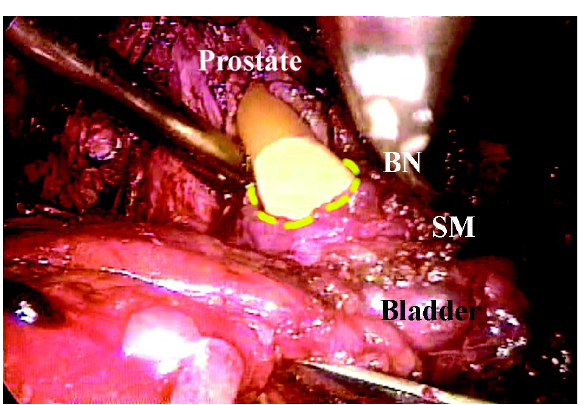
Figure 9 – Identification and opening of the anterior layer of Denovilliers’ fascia posterior to the prostate with viewing of vasa deferentia. P= prostate, DF= Denovilliers’ fascia, VD= vas deferens.